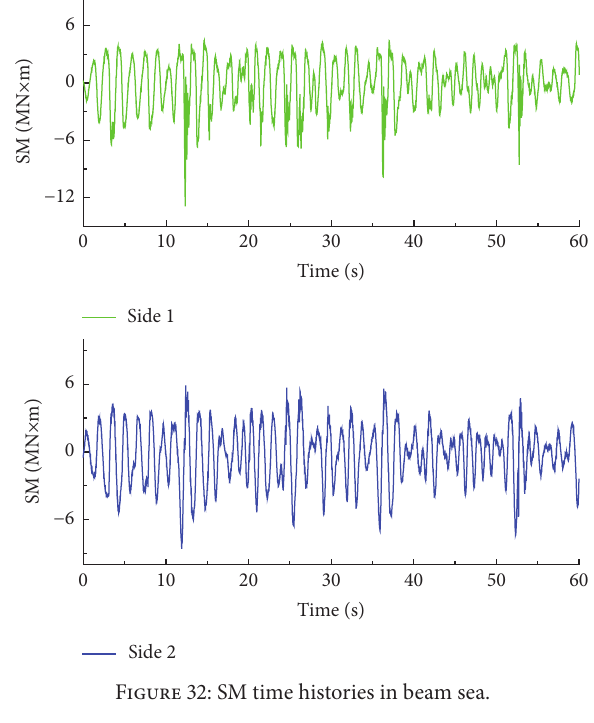
Figure 32: SM time histories in beam sea.